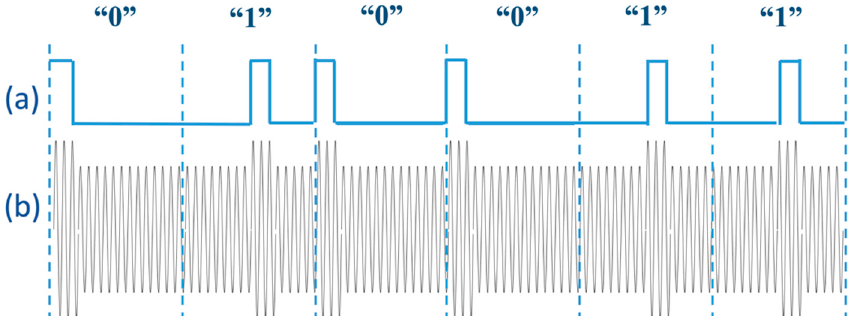
Figure 4. The schematic of the load-shift keying data modulation is shown. ( a ) The digital sequences of “0”s and “1”s are encoded by differential pulse position algorithm at the implantable unit, and ( b ) the encoded data modulated over 13.56 MHz carrier signal, can be seen by the envelope detector at the wearable unit. It only presents the concept and does not take into consideration instantaneous possible changes of the transmitting power.